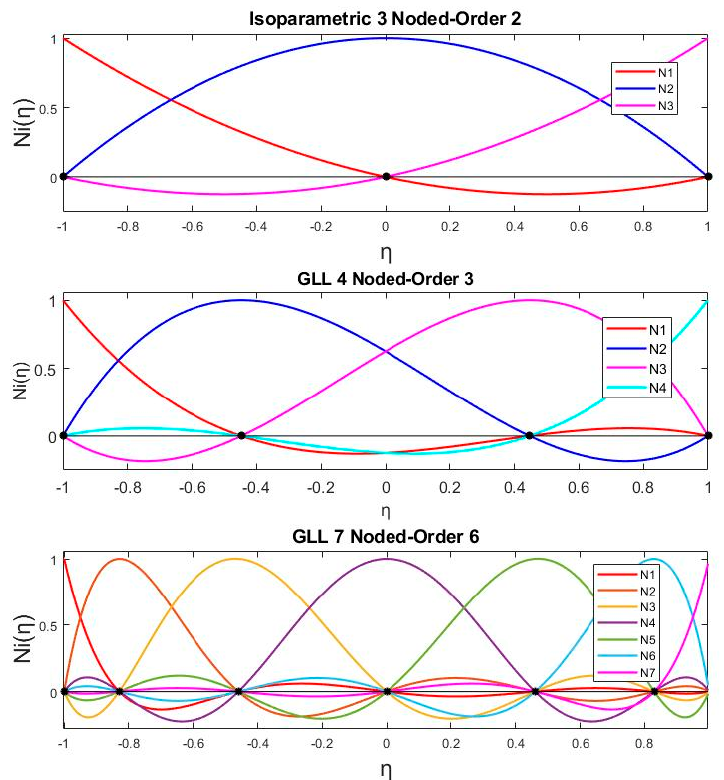
Figure 2. Lagrange shape functions for GLL quadrature points.